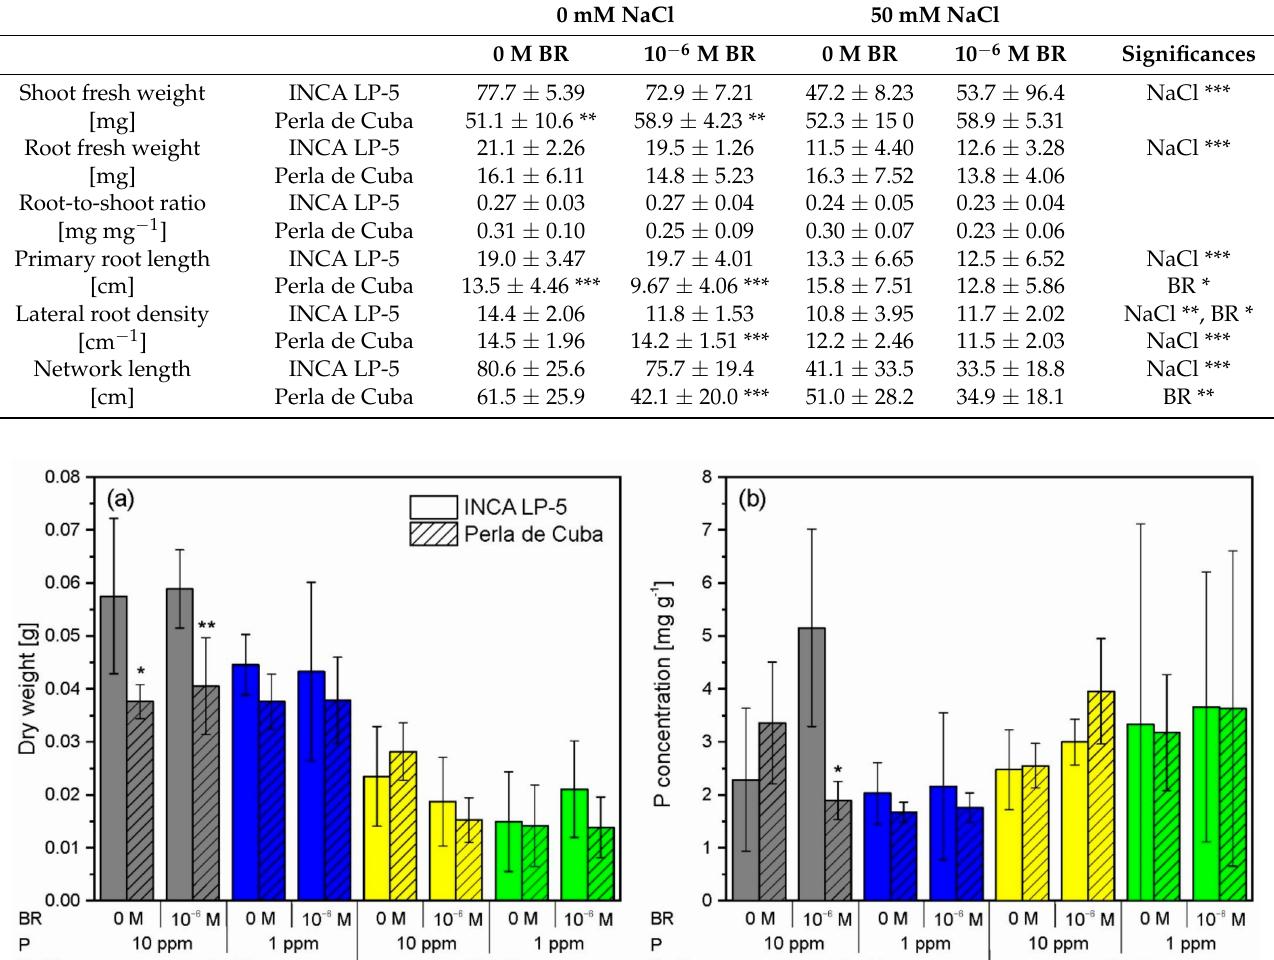
Table 2. Root parameters of the two rice cultivars INCA LP-5 and Perla de Cuba after seven days of growth in cigar rolls with or without salt (NaCl) and 24-epibrassinolide (BR) pre-treatment (mean ± SD). Significance of factors NaCl, BR and their interactions after ANOVA ( p < 0.05 * 0.01 ** 0.001 ***) are given for both cultivars. Significant differences between cultivars in each treatment are indicated.